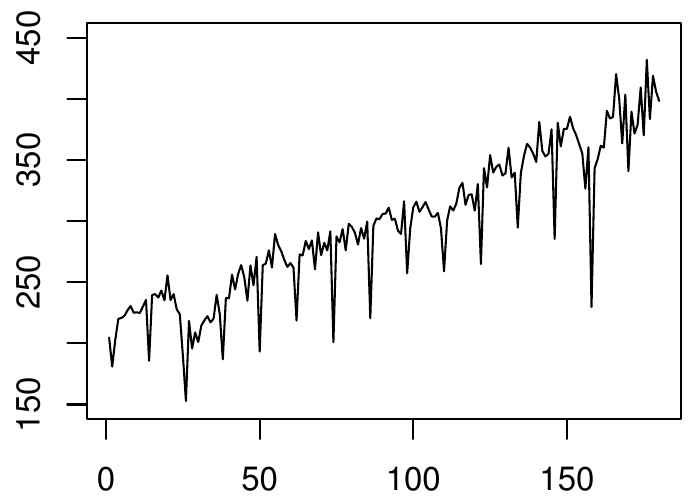
Figure 2. The monthly container throughput of Shanghai